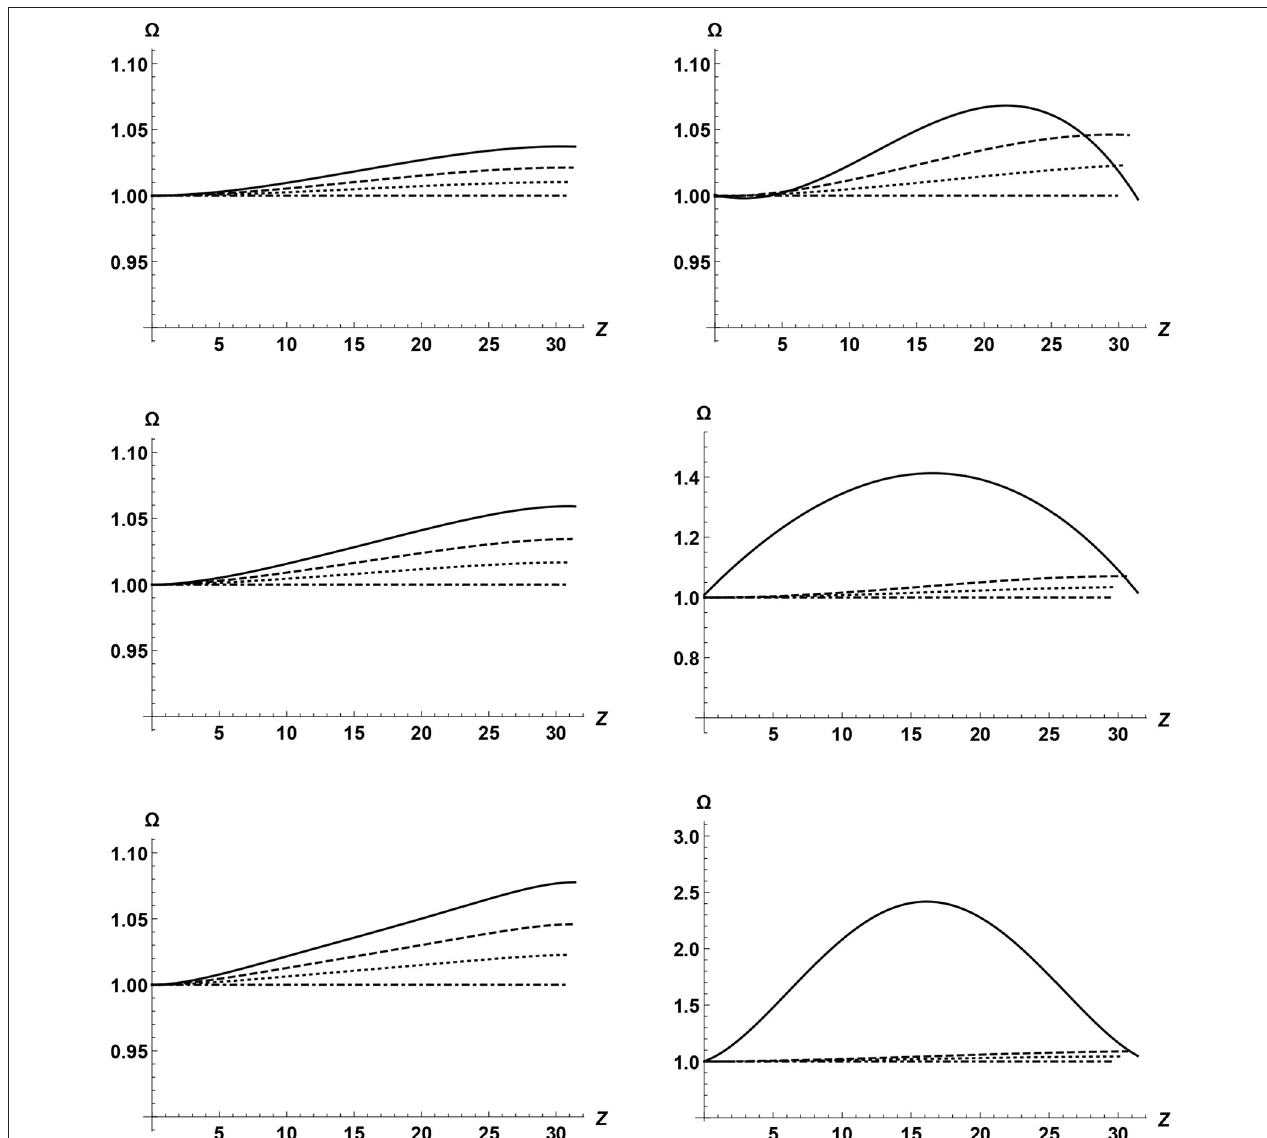
1 and the right to λ =